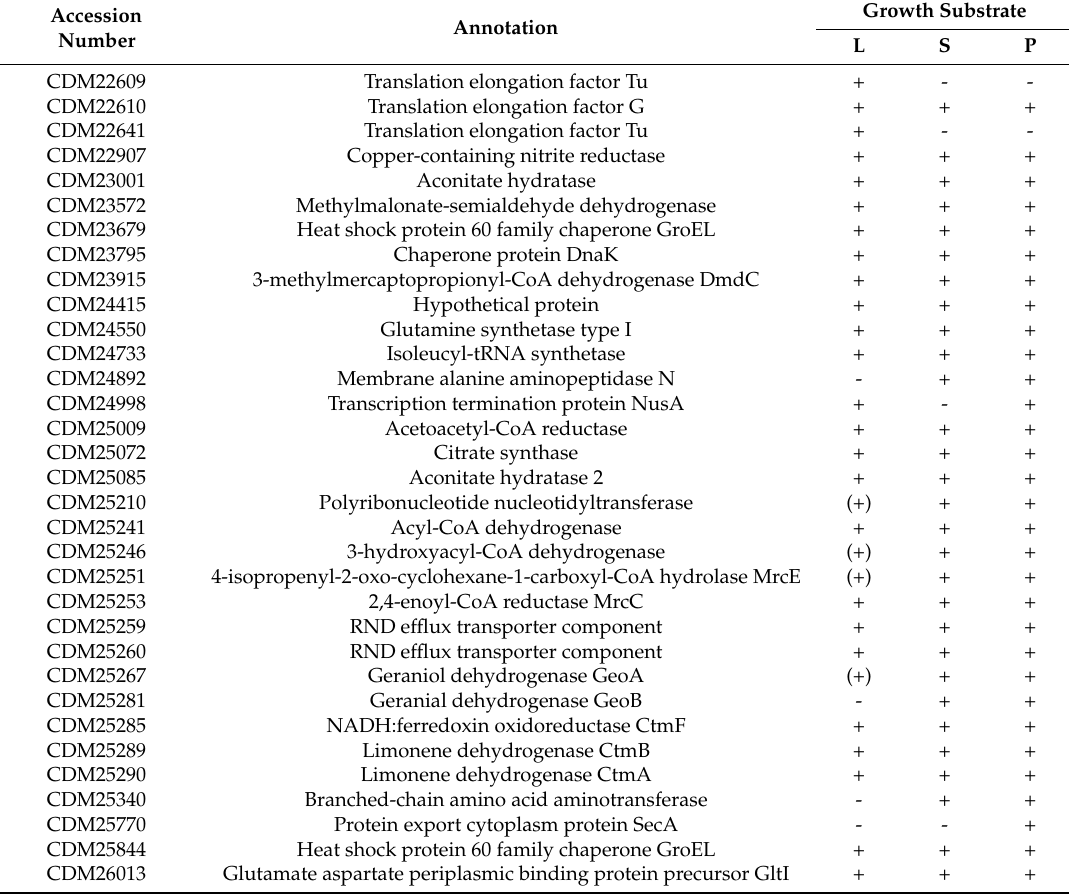
Table 2. Proteins of C. defragrans 65Phen present in larger amounts in cells grown on monoterpenes compared to cells grown on acetate. Proteins were fractionated with anion exchange chromatography, semi-quantified by SDS-PAGE (In-gel protein band intensity: +, observable; (+) weakly observable; -, not visible) and identified by MALDI-ToF-MS. Carbon source: L, R-(+)-limonene (monocyclic); S, sabinene (bicyclic); P, α -pinene